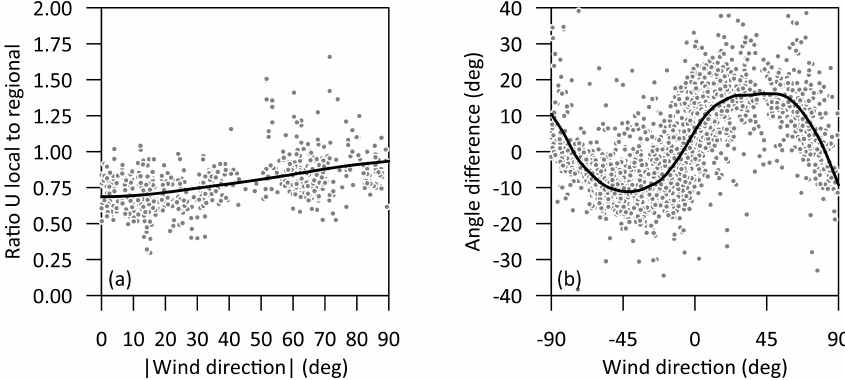
Figure 6. Correction of regional (IJmuiden) to local (Egmond beach) wind data. ( a ) shows the ratio of local to regional wind speed versus the absolute value of the regional wind direction with respect to the shore normal, | θ SN | . Local wind speeds were measured at 0.9 m above the bed and were corrected to the same height above ground (10 m) as where the regional values were measured, assuming a logarithmic velocity profile and a roughness length z 0 of 1 × 10 − 4 m. The panel contains all 730 observations (dots) taken on the intertidal beach during Aeolex-II and the smooth trend line. ( b ) shows the observed (dots; Aeolex-II) difference between the wind direction at the beach-dune transition and at IJmuiden versus the regional wind direction with respect to the shore normal, θ SN . The line is the smooth trend line. This panel contains about 2950 observations. Shore-normal onshore wind (i.e., coming from 277 ◦ N) has θ SN = 0 ◦ ; negative and positive angles on the x -axis in ( b ) represent winds coming the southwest and northwest, respectively. Because the local to regional wind speed ratio ( a ) was symmetric with respect to θ SN , the absolute value of the direction was used to better constrain the trend line. The